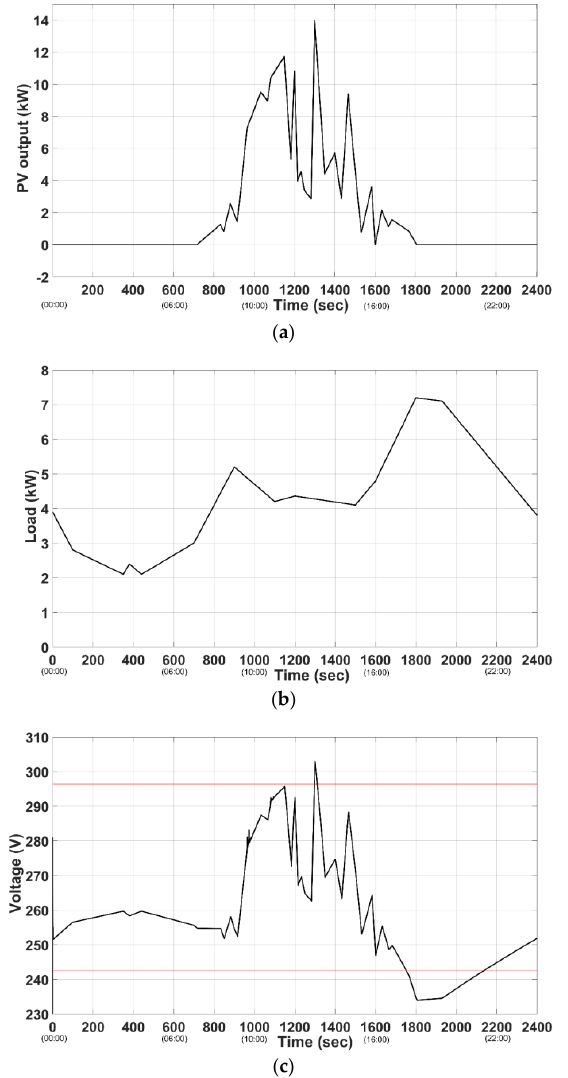
Figure 14. Bus 7: ( a ) the PV generation, ( b ) the total load and ( c ) the voltage profile and the maximum and minimum allowable voltage values.